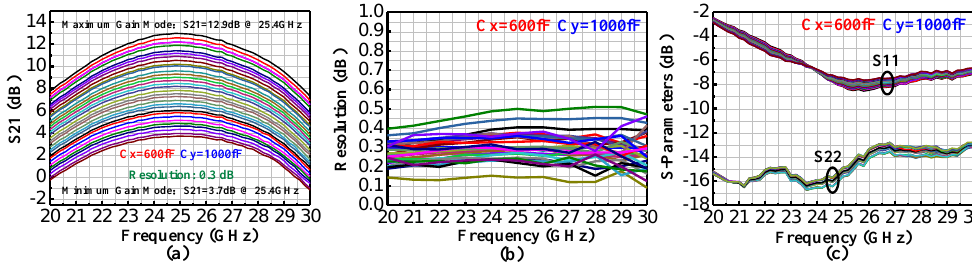
Figure 8. Based on C x = 600 fF, C y = 1000 fF (Ctr1 = 1 V, Ctr2 = 0 V): ( a ) measured 32 gain states versus frequency and ( b ) its corresponding 31 gain resolutions versus frequency; ( c ) measured S11 and S22 versus frequency at 32 control states.